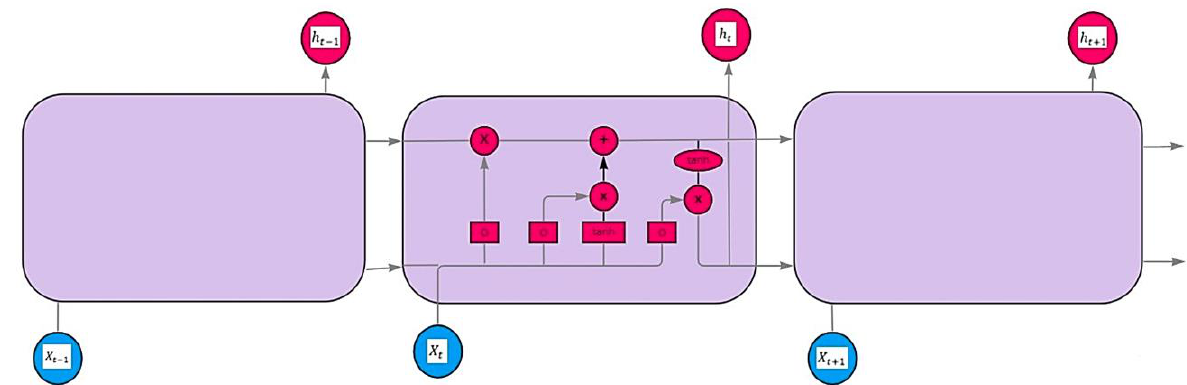
Figure 14. LSTM general structure.